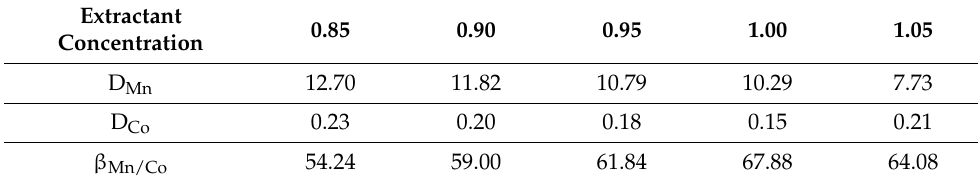
Table 4. The relationship between the equilibrium pH and separation coefficient. Extractant